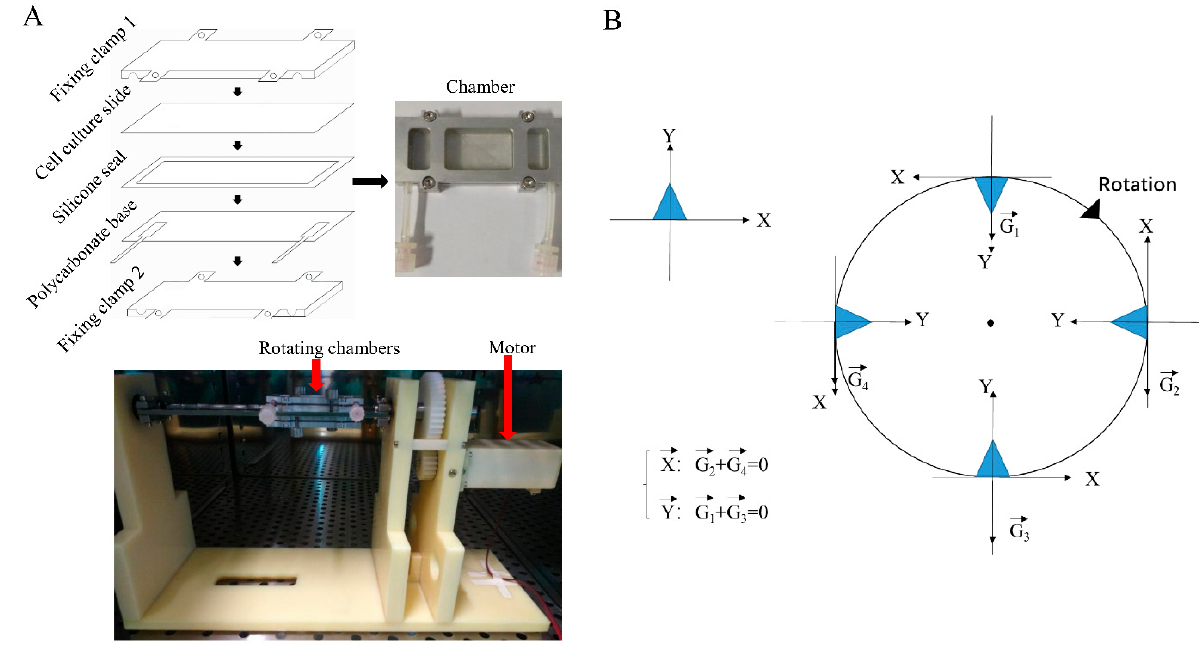
Figure 2. Simulated microgravity rotary flat chamber bioreactor and schematic diagram of BMSCs feeling gravity. ( A ) Construction of a chamber and photograph of the 2D-clinostat in the present study to model simulated microgravity. ( B ) The principle of the clinostat is utilized to simulate microgravity. The rectangular coordinate system based on BMSCs is established. When BMSCs are attached to the cell culture slice, rotation causes that the gravity vector is not recognizable to BMSCs. In other words, the orientation of the cells changes constantly, and the gravity vector changes accordingly. After one rotation, the gravity vector is zero, which means that the average gravity vector is 0 g. BMSCs: bone marrow-derived mesenchymal stem cells.